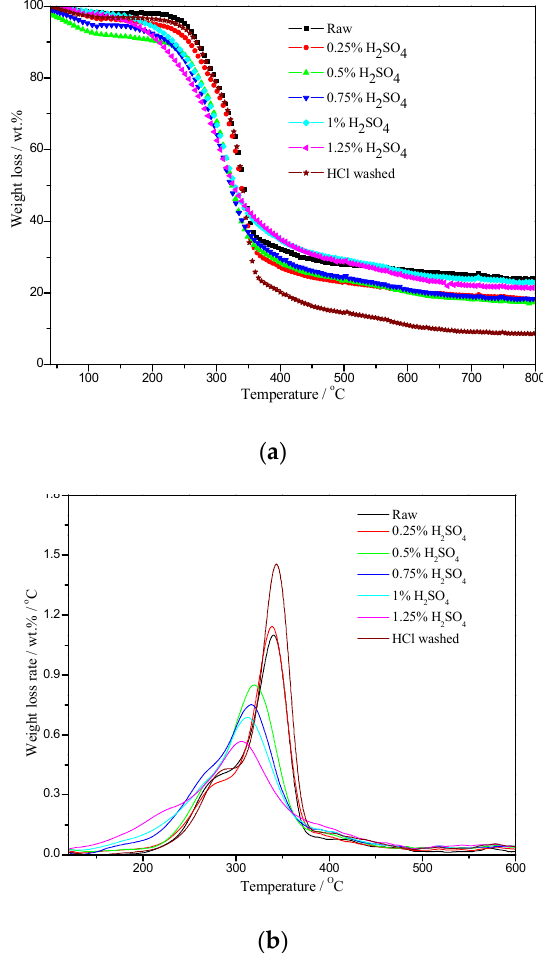
Figure 2. Thermogravimetric (TG) and differential thermal gravity (DTG) analysis of raw and H 2 SO 4 -impregnated eucalyptus: ( a ) TG curves of raw and H 2 SO 4 -impregnated eucalyptus, ( b ) DTG curves of raw and H 2 SO 4 -impregnated eucalyptus.